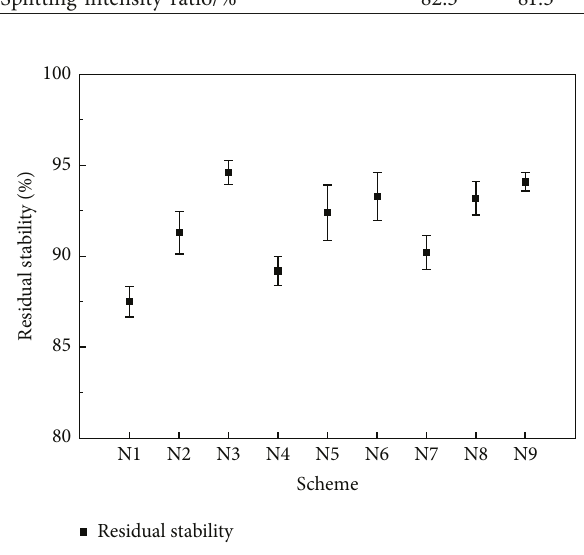
Figure 11: Results of immersion Marshall test.